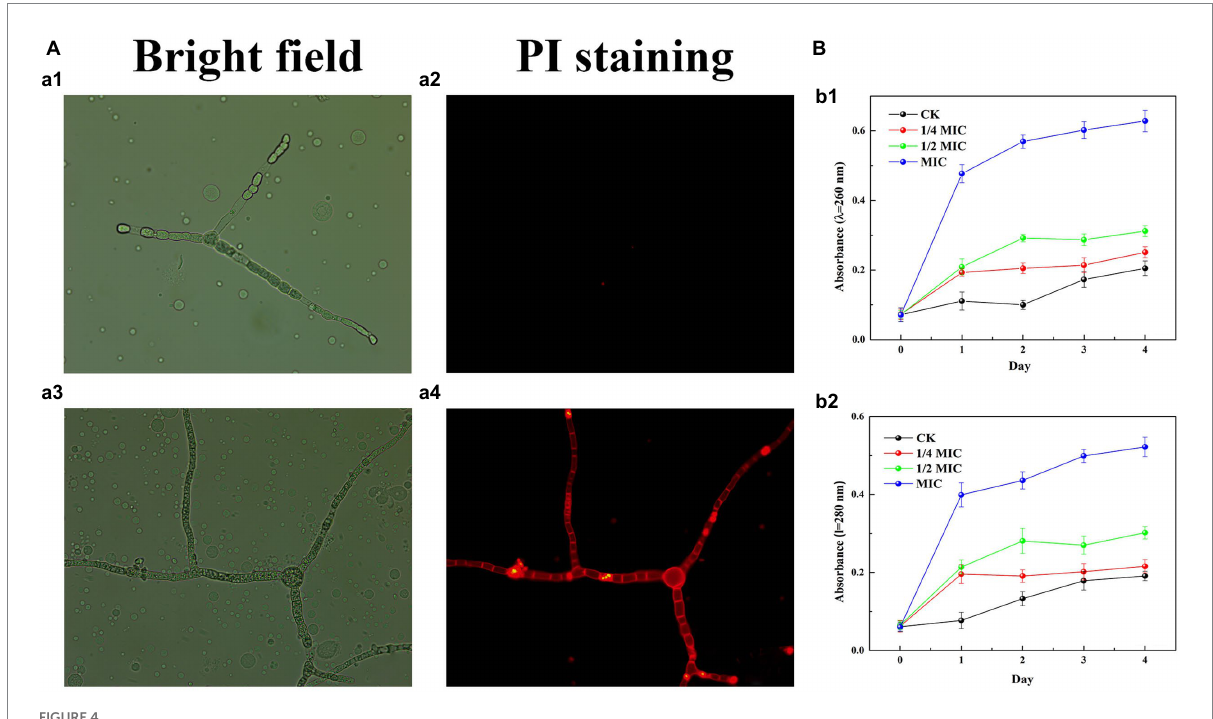
FIGURE 4 (A) Effects of 2,3-butanedione on plasma membrane integrity ( A1 , A2 : control group, a3-a4: treatment group with 2,3-butanedione, First row: bright field. Second row: propidium iodide). (B) Determination of absorbance value at 260 nm (B1) and 280 nm (B2) by 2,3-butanedione